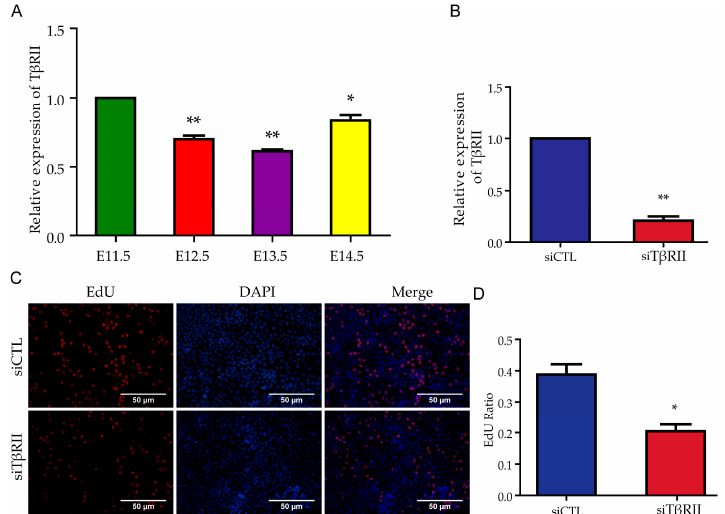
Figure 1. TGF β type II receptor ( T β RII ) promotes the proliferation of mK3 cells. ( A ) The expression pattern of T β RII at mRNA level of embryo kidney from E11.5 to E14.5; ( B ) The mRNA level of T β RII in mK3 cells after the treatment of siT β RII; ( C ) The proliferation rate of mK3 cells after the transfection of siT β RII; ( D ) Histogram shows the quantitative analysis of the 5-ethynyl-2 ′ -deoxyuridine (EdU) assay. All data are displayed as means ± Standard Deviation (SD) from three independent experiments, * p < 0.05, ** p < 0.01.